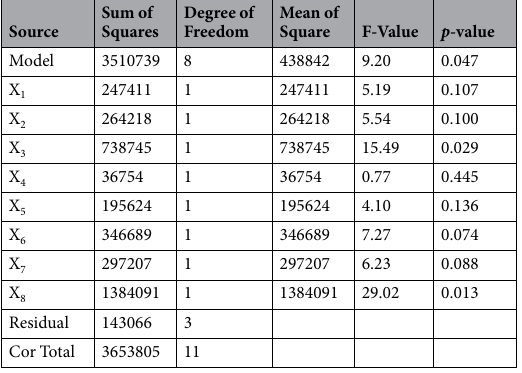
Table 3. ANOVA for the Plactkett-Burman factorial model. R 2 = 0.9608, Adj R 2 = 0.8564.